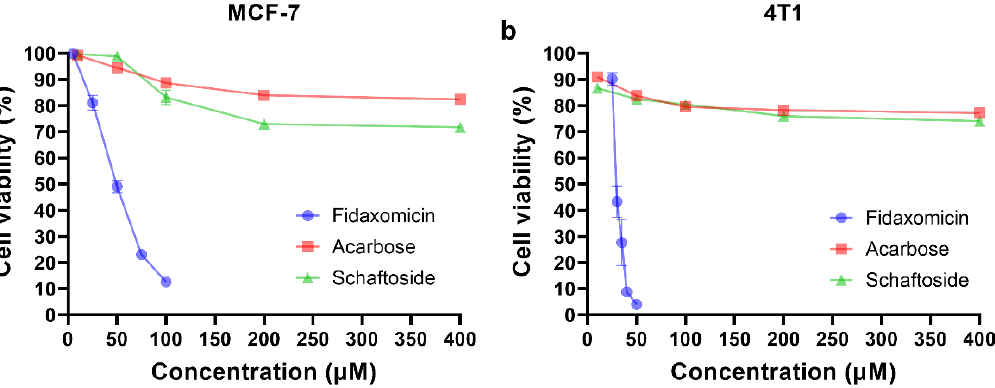
Figure 5. In vitro cytotoxicity analysis. ( a ) Cytotoxicity test in human breast cancer MCF-7 cells. ( b ) Cytotoxicity test in mouse breast cancer 4T1 cells. The cells were incubated with various concentrations of fidaxomicin, acarbose, or schaftoside for 48 h, and the viability of cells was examined by CCK-8 assay ( n = 5 samples per group).